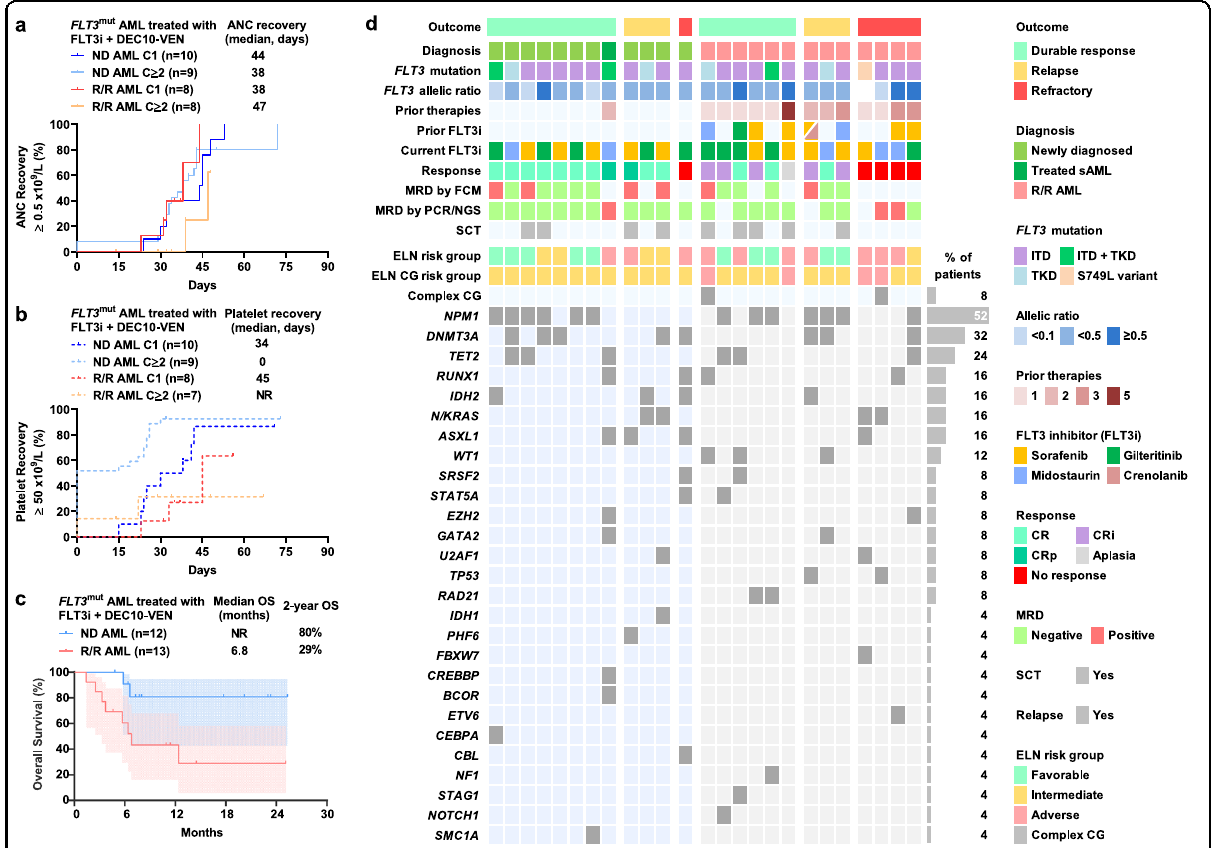
Fig. 1 Outcomes of patients with newly diagnosed (ND) and relapsed/refractory (R/R) acute myeloid leukemia with FLT3 mut treated with FLT3 inhibitor (FLT3i), venetoclax, and 10-day decitabine (DEC10-VEN). a Absolute neutrophil count (ANC) recovery to ≥ 0.5 × 10 9 /L, b platelet count recovery to ≥ 50 × 10 9 /L, and c overall survival (OS), and d mutational landscape of all patients. NR not reached, MRD measurable